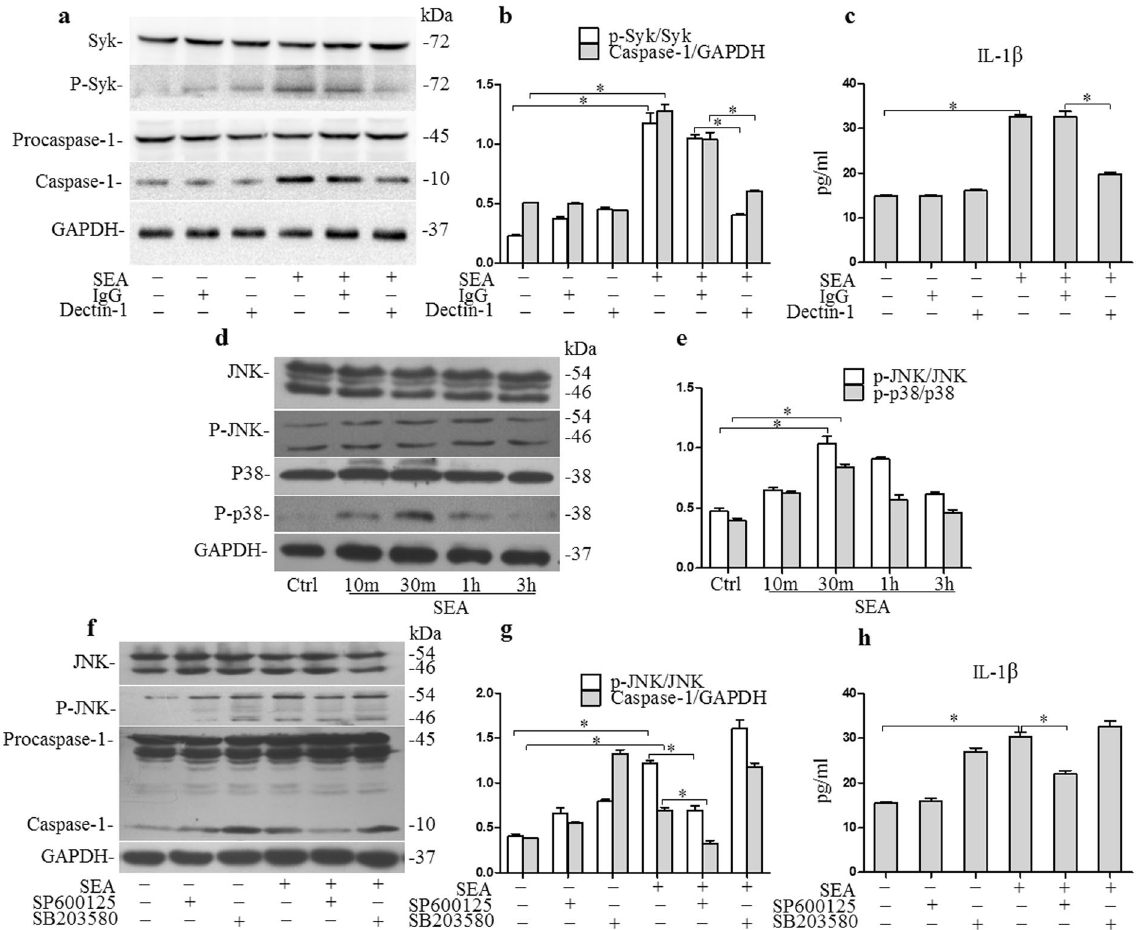
Figure 7. Dectin-1 and JNK are involved in NLRP3 inflammasome activation: ( a ) western blot gels and ( b ) summarized data showing the expression of Syk, p-Syk (Y525/526), procaspase-1, activated caspase-1 and GAPDH in HSCs incubated with or without SEA (50 μ g/ml) in the presence or absence anti-Dectin-1 antibody, full-length blots are included in the Supplementary Fig. S11, ( c ) IL-1 β production in cell supernatant; ( d ) Western blot gels and ( e ) summarized data showing the expression of JNK, p-JNK (Thr 183 + Tyr 185), p38, p-p38 and GAPDH in HSCs after stimulation with SEA (50 μ g/ml), full-length blots are included in the Supplementary Fig. S12; ( f ) Western blot gels and ( g ) summarized data showing the expression of JNK, p-JNK (Thr 183 + Tyr 185), procaspase-1, activated caspase-1 and GAPDH in HSCs incubated with or without SEA (50 μ g/ml) for 2 h in the presence or absence inhibitors for JNK (SP600125) and p38 (SB 203580), full-length blots are included in the Supplementary Fig. S13, ( h ) IL-1 β production in cell supernatant. Results are a representative of at least three independent experiments. * p <